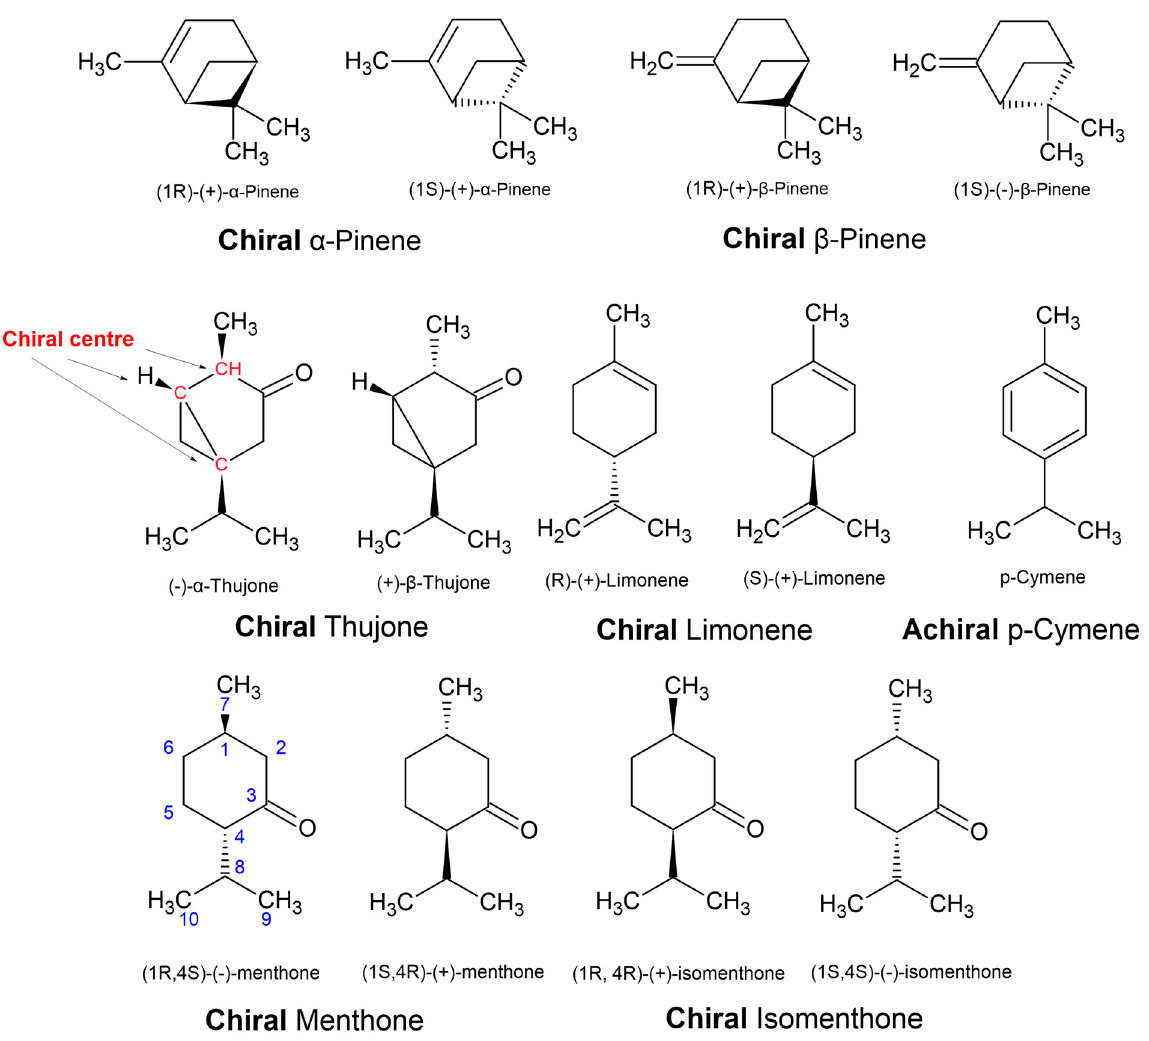
Figure 14. Enantiomers of chiral compounds, such as thujone, limonene, and